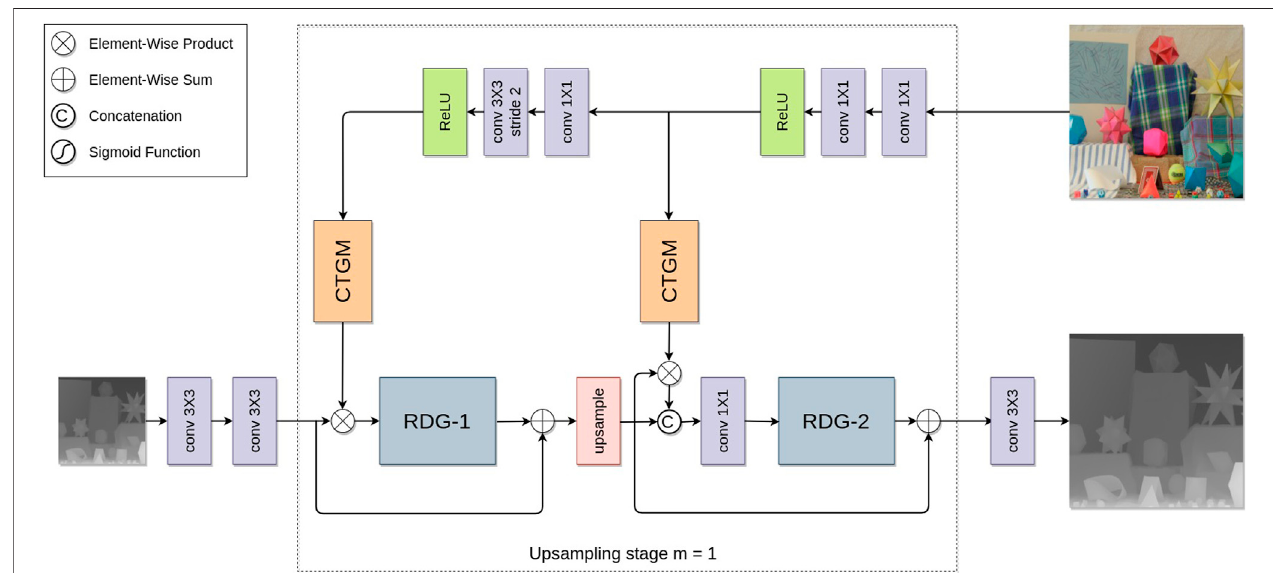
FIGURE 1 | Our proposed architecture for guided depth SR for an upsampling factor of 2. The dashed square marks a single upsampling stage i that can be duplicated according to the desired upsampling factor s =2 m .